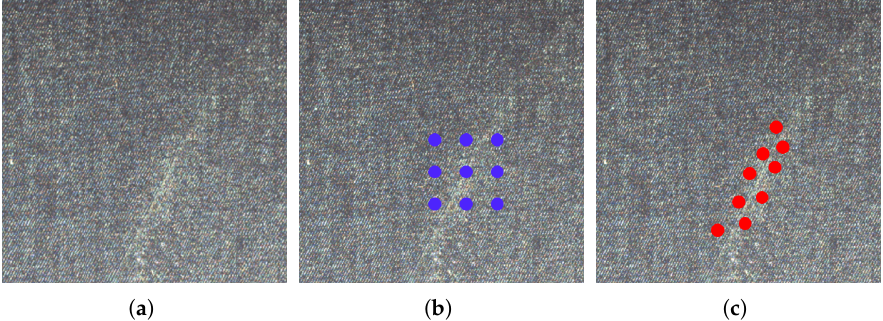
Figure 5. Different convolutions. ( a ) Defective image; ( b ) traditional convolution with the kernel size of 3 × 3; ( c ) deformable convolution with the kernel size of 3 × 3 .